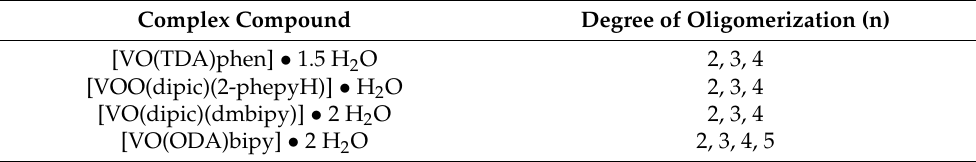
Table 6. Degree of oligomerization for 2,3-dibromo-2-propen-1-ol oligomers obtained using oxovana- dium(IV)